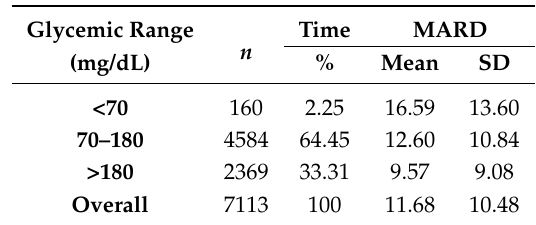
Table 8. Samples separated per glycemic range. Time (%) and mean absolute relative difference (mean and standard